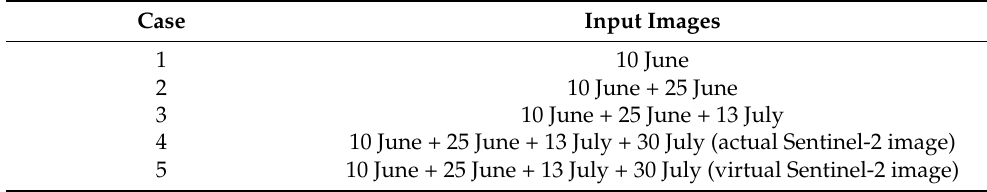
Table 7. Incremental classification cases considered for early crop mapping.